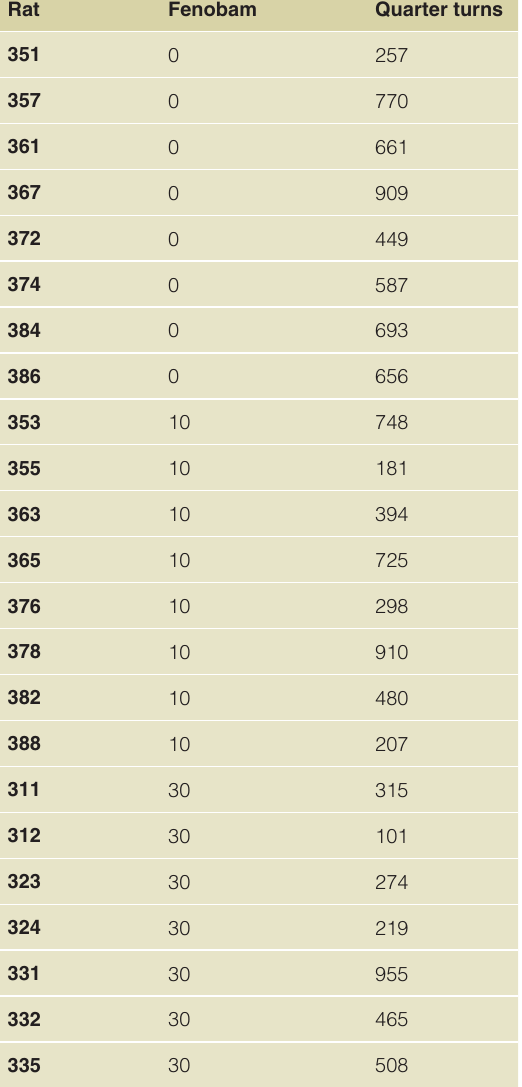
Table S8. Fenobam (0, 10, 30 mg/kg) effects on METH locomotor response – history of METH injections.